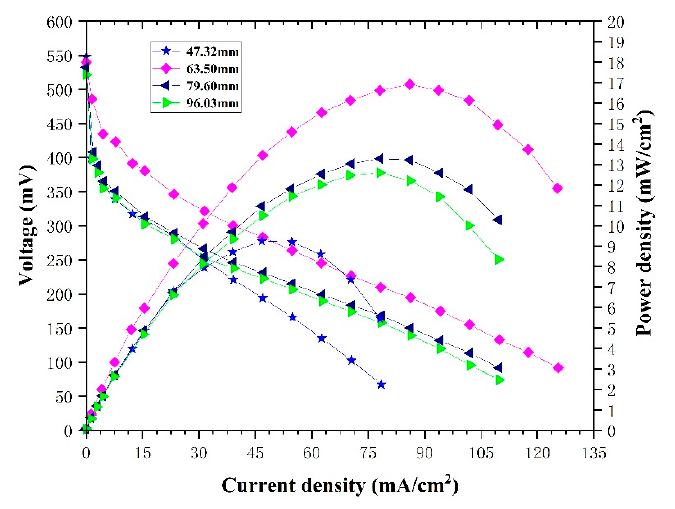
Figure 14. Polarization curves and power density curves of single-serpentine flow fields with different channel lengths under the same experimental conditions.